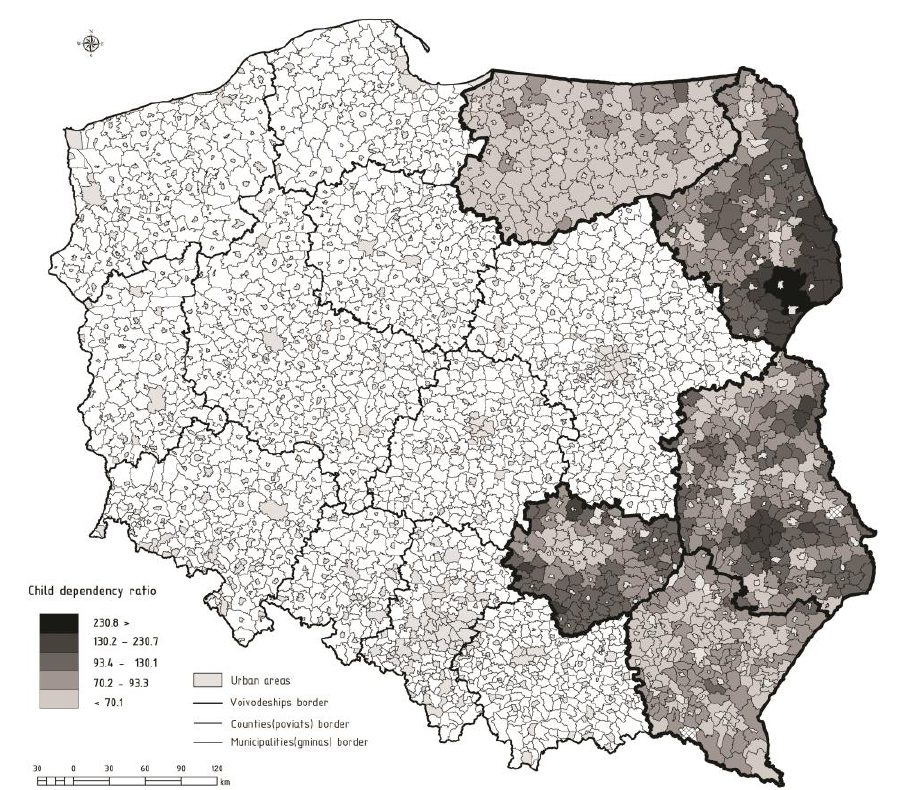
Fig. 9. Post-working age population per 100 persons of pre-working age in rural areas of Eastern Poland in 2008 (Source: